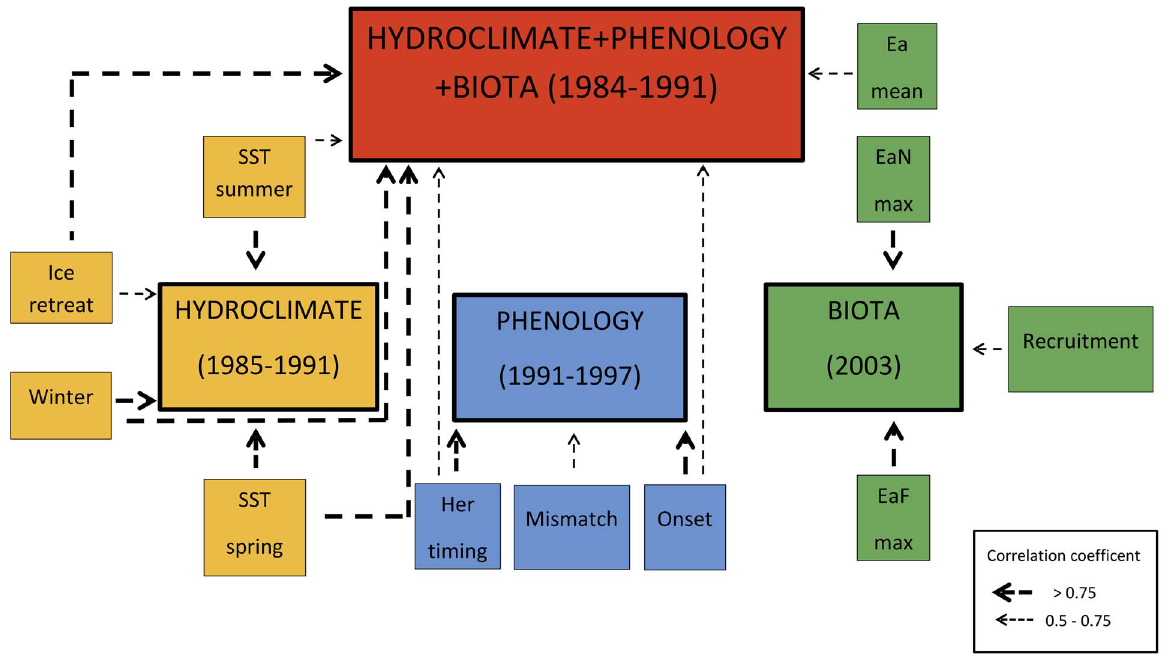
Figure 7. Flow-chart for schematic representation of significant factors that contributed to shifts in the Gulf of Riga for the period of 1957–2010 by different sub-sets (hydroclimate, phenology, biota) and jointly for the all nineteen variables (hydroclimate +- phenology + biota). Years referred under different sub-sets indicate timing and duration of a shift. Arrows indicate the suggested causal link between the discriminated categories. All individual factors displayed by sub-sets contributed significantly to the shift in particular sub-set while the underlined parameters contributed significantly to a shift in time series pooling all nineteen variables. Abbrevations in figure are; SST spring and summer: sea surface temperatures in spring and summer, ice retreat: timing of ice retreat, winter: winter air temperature, her timing: timing of maximum abundance of herring larvae, mismatch: degree of temporal mismatch between larval herring and Eurytemora nauplii, onset: herring larvae onset, Ea mean: adult Eurytemora affinis , mean abundance, EaN max: Eurytemora nauplii maximum abundance, EaF max: female Eurytemora affinis maximum abundance, recruitment: herring recruitment.